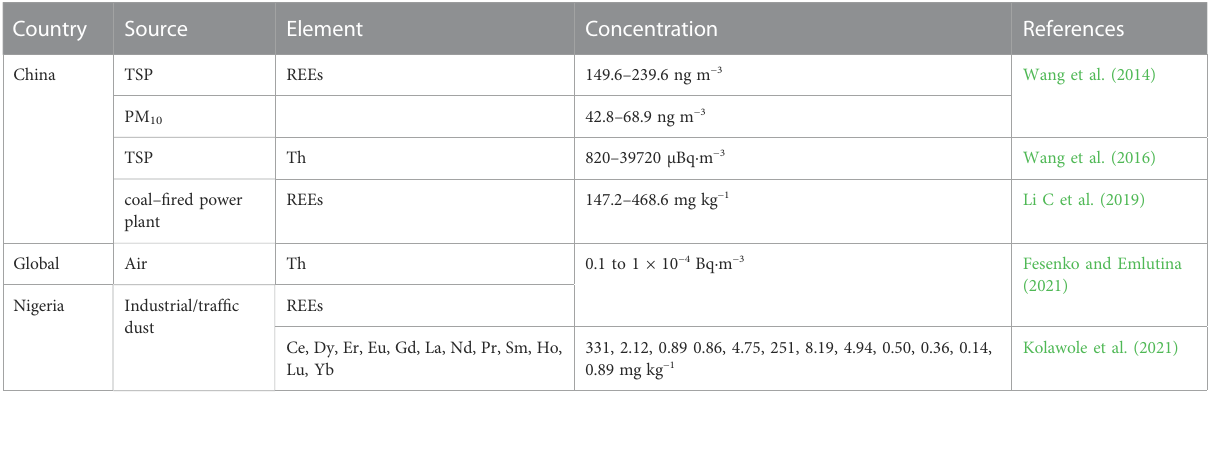
TABLE 3 Contents of U, Th and REEs in ambient air.